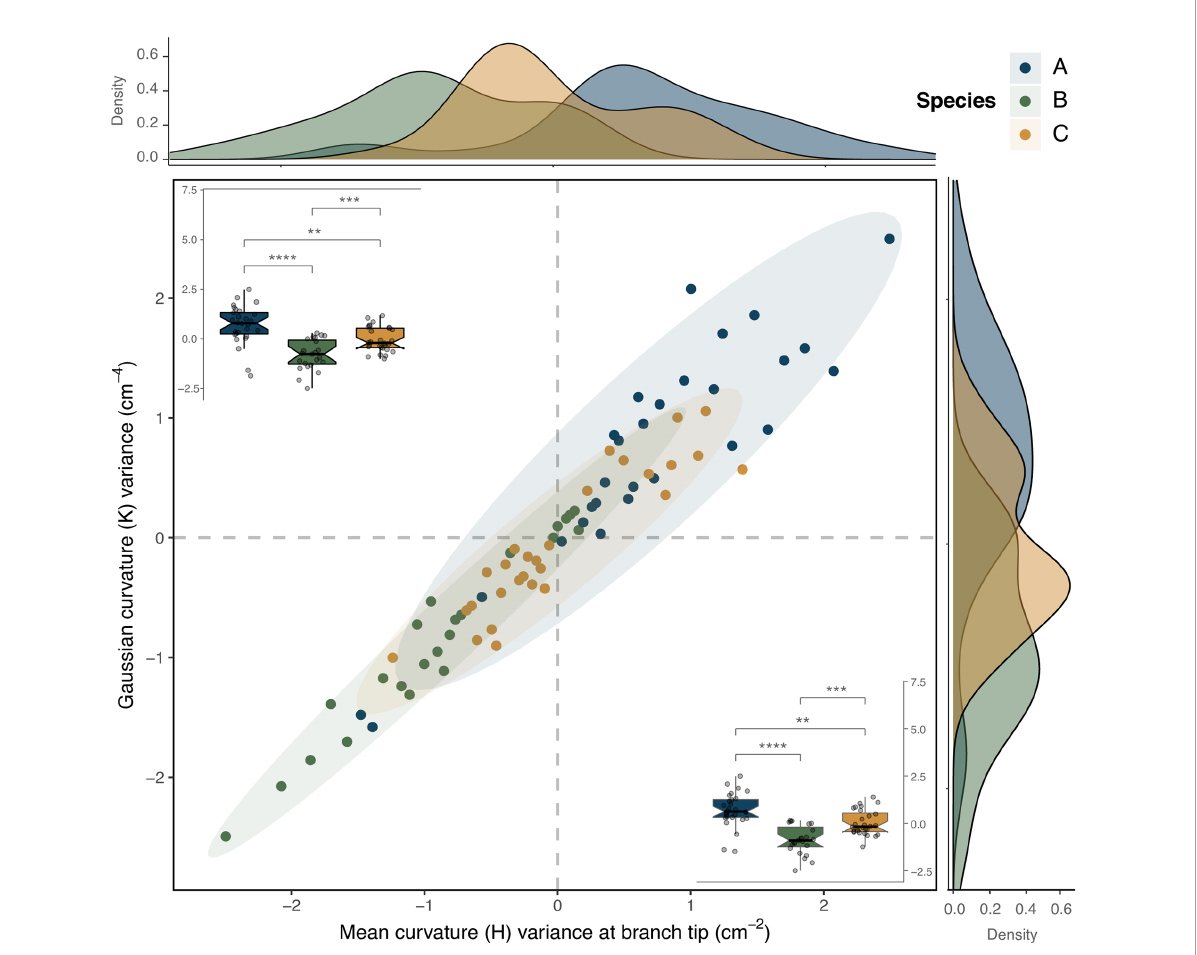
FIGURE 3 Comparison of two correlated curvature variables that displayed signi fi cant differences between the three species (ANOVA and post-hoc Tukey tests, a = 0.05), but where the species morphospaces overlapped: mean curvature variance at branch tip vs. Gaussian curvature variance ( H_tip_var vs. K_var ). In the center, a scatter plot depicts the two variables, correlation (Pearson correlation coef fi cient r = 0.96), along with their density distributions along each axis. Box plots in each corner display the signi fi cant differences in the mean values of the variables according to pairwise interspeci fi c comparisons ( p -values signi fi cance: ** ≤ 0.01, *** ≤ 0.001, **** ≤